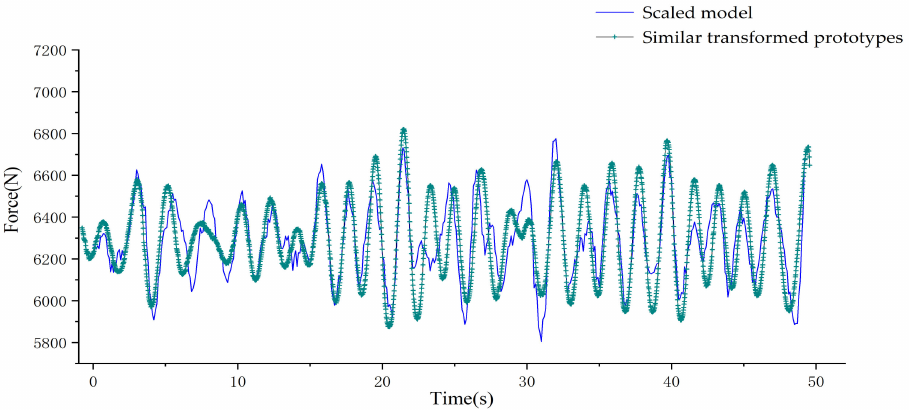
Figure 7. Force comparison at the articulation of support components under tower and tensioner support.